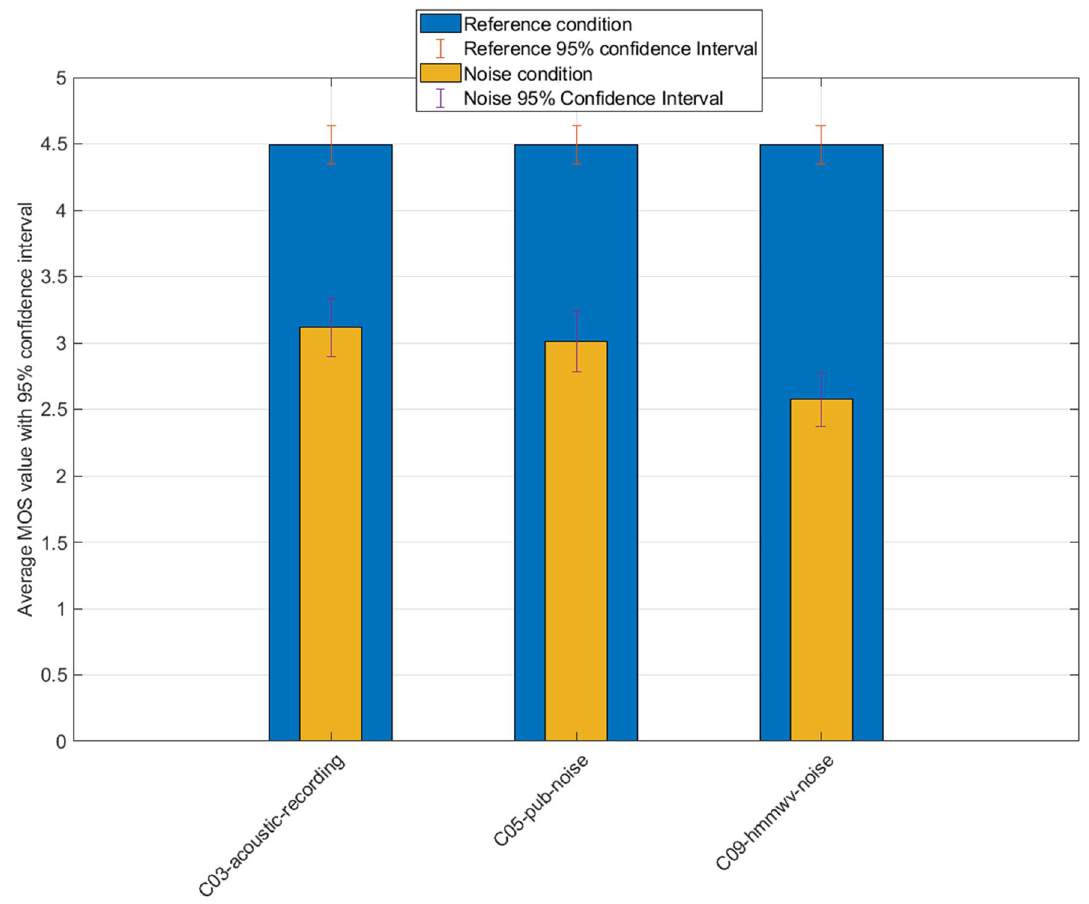
Figure 3. Results of reference studio condition and noise conditions without